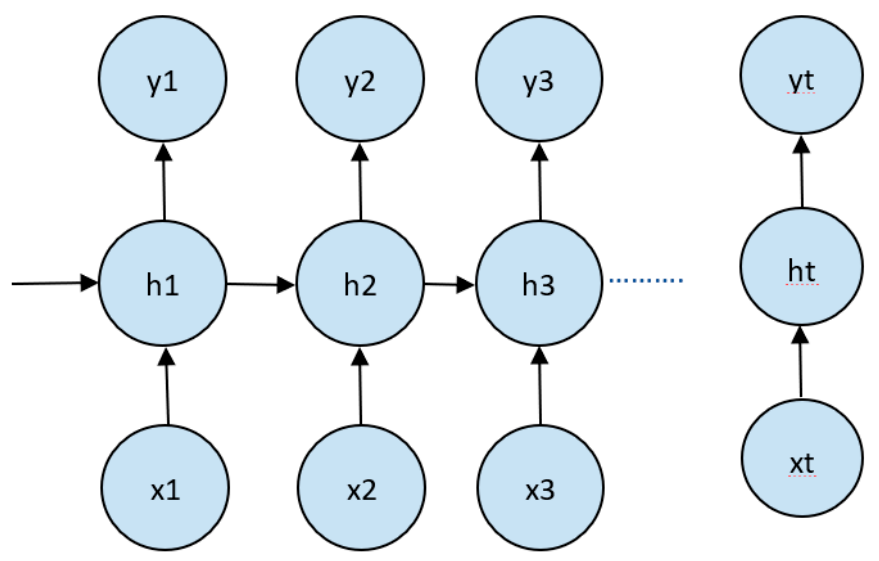
Figure 1. An un-rolled recurrent neural network.